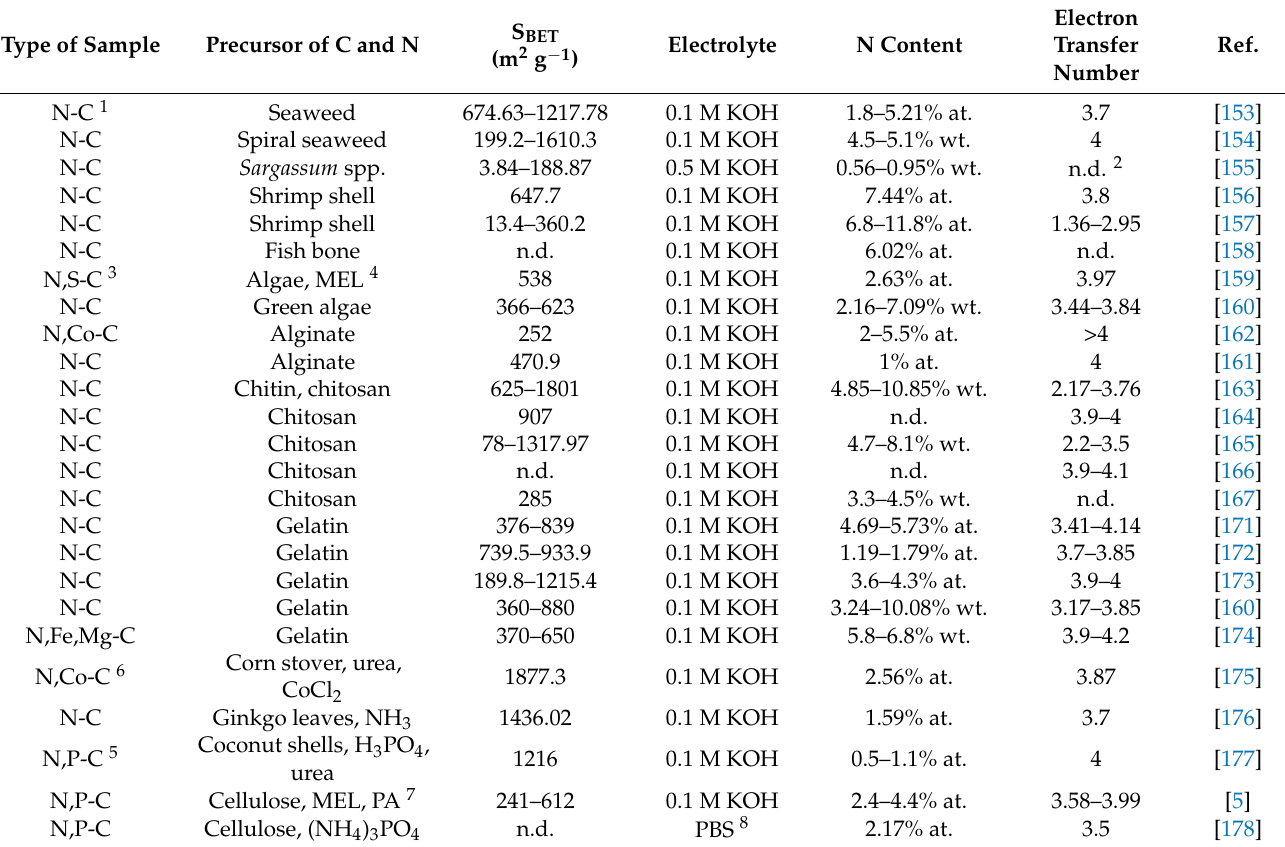
Table 6. Summary of nitrogen-doped porous carbons derived from natural precursors as electrocata- lysts for